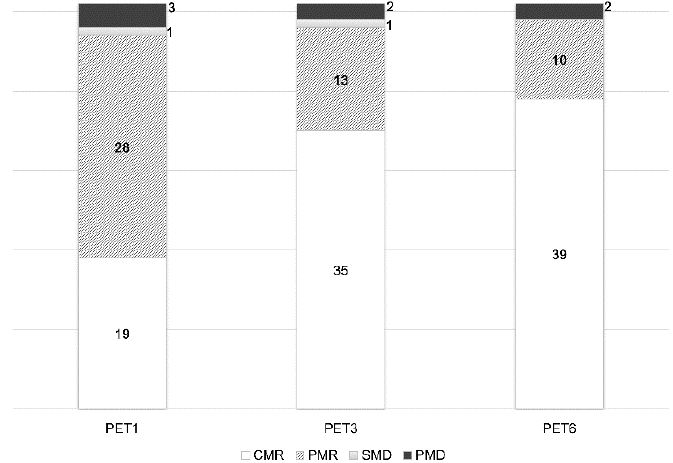
Figure 2. Number of cases at different time points for metabolic response categories according to PERCIST 1.0.